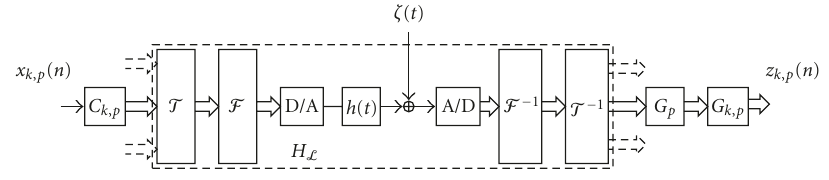
Figure 2: Continuous and discrete-time equivalent SS-OFDM